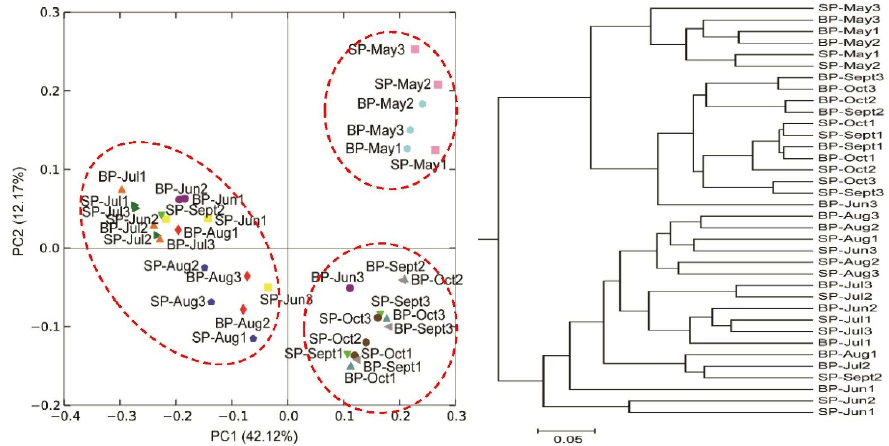
Figure 4. PCoA ( left ) and UPGMA ( right ) clustering based on weighted UniFrac distance at the OTU levels. BP, large area pond; SP, small area pond; May–Oct. indicate sampling time; 1, 2, and 3 represent three duplicate ponds.